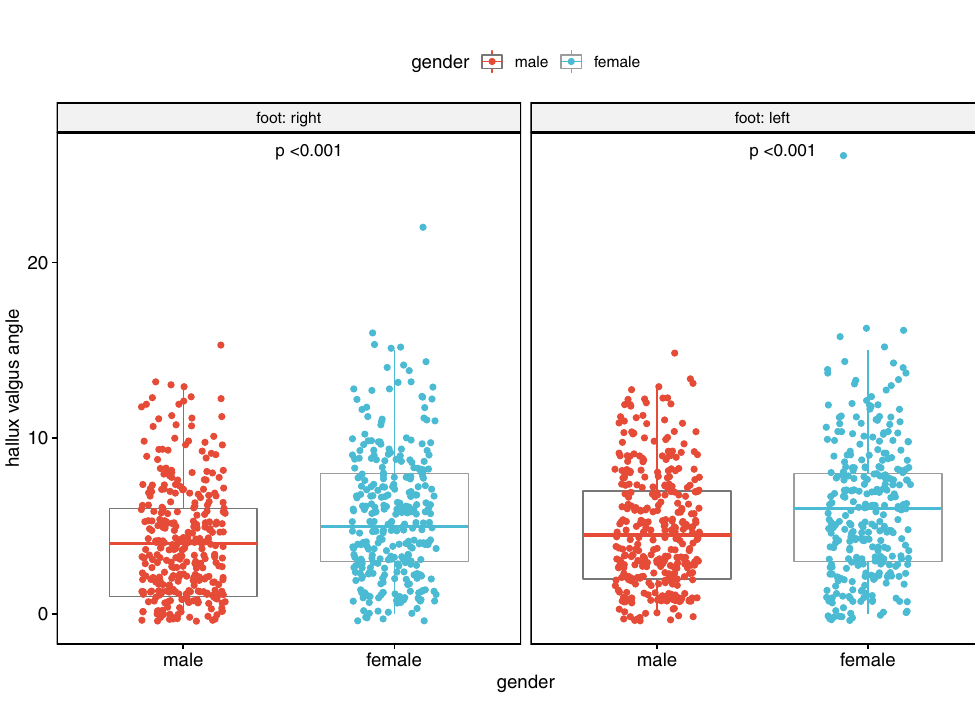
Figure 4. Dependence of the hallux valgus angle on gender 15,16